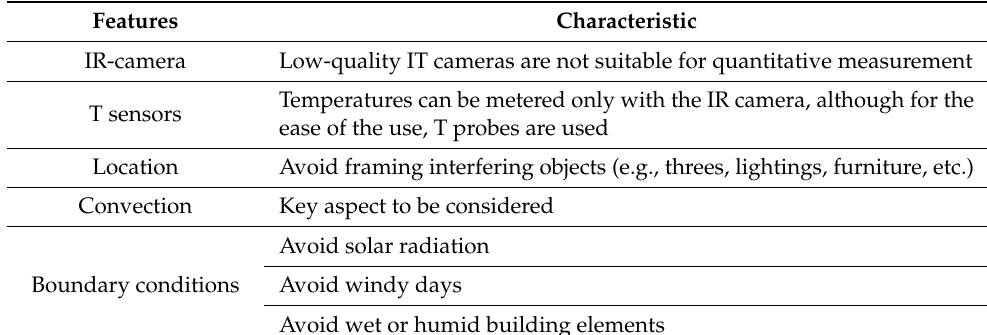
Table 10. Characteristics of the QIRT method (source: authors’